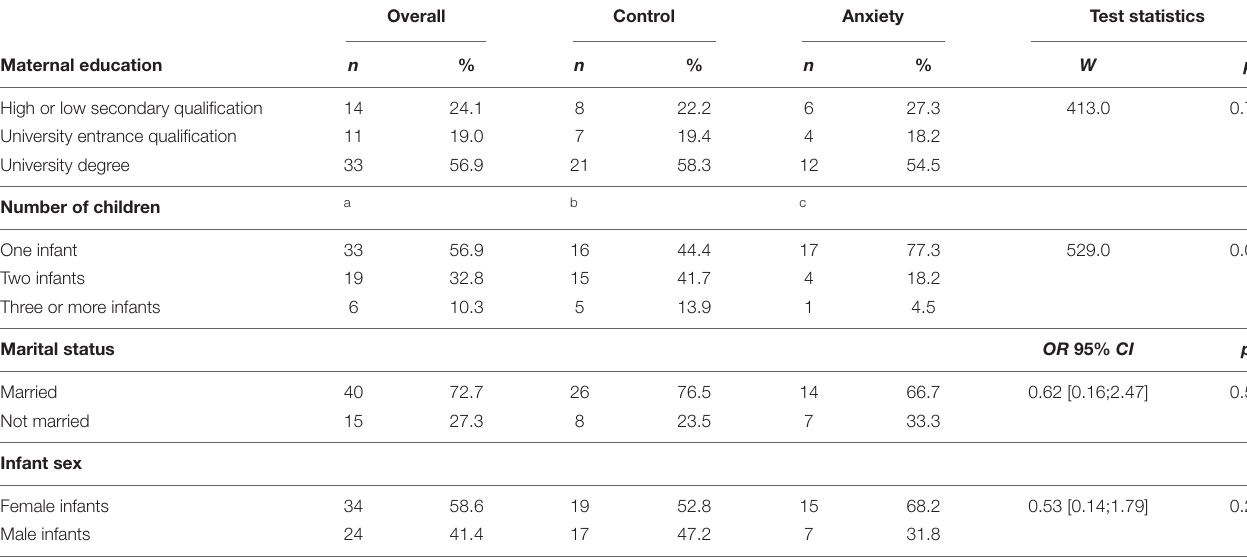
TABLE 1B | Maternal and infant non-parametric demographics and tests on comparability of subgroups 3–8 months postpartum (Study 1). Overall Control Anxiety Test